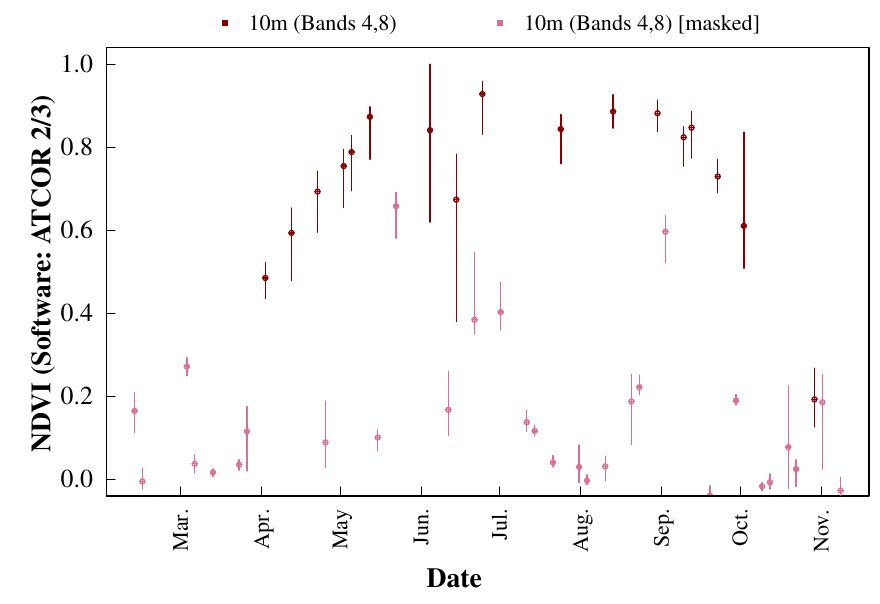
Figure 3. Sentinel-2A NDVI time series from 2016 with 10-m resolution processed with ATCOR 2/3. The lines show the distribution of NDVI values of pixels in an area within 30 m around the eddy flux tower. The dot marks the respective median value. The NDVI of clear pixels are shown in dark colors, whereas pixels with clouds, shadows or saturation are shown in pale colors (masked